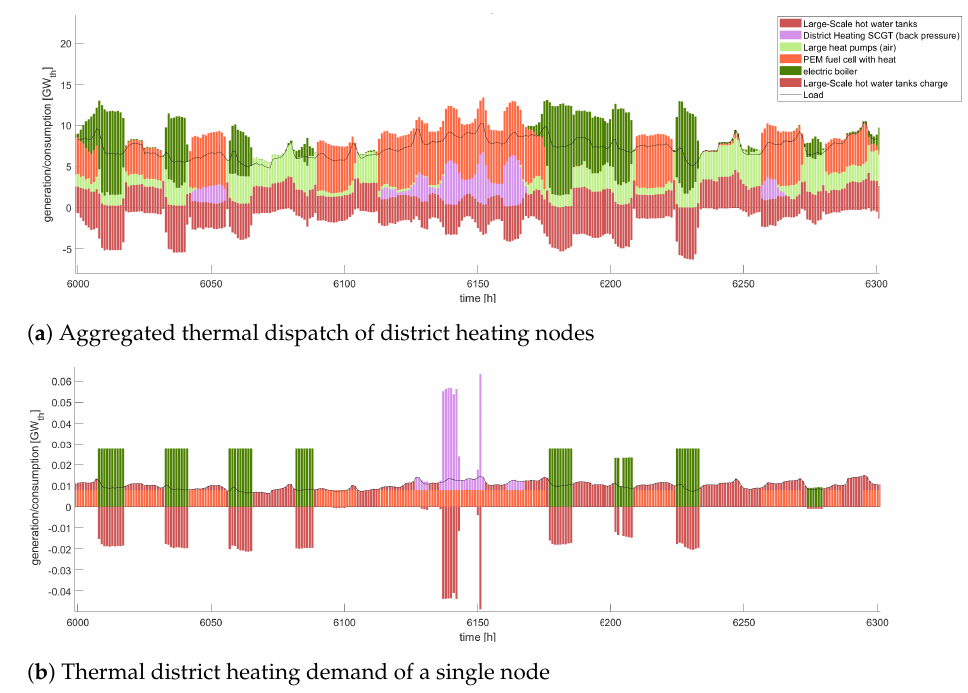
Figure 14. District heating operation in scenario